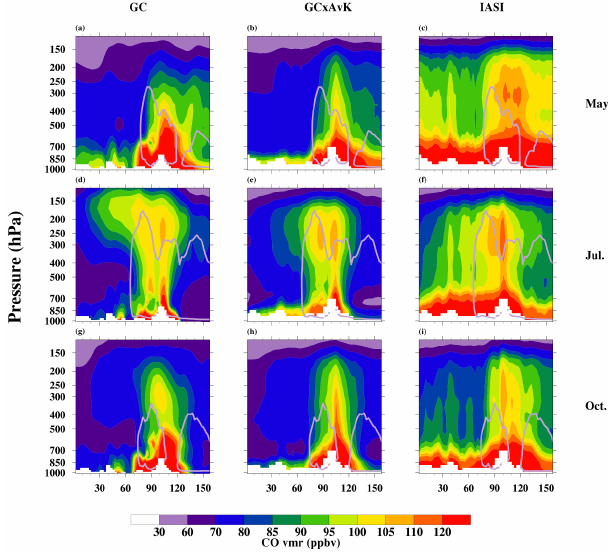
Figure 3. Latitude–pressure cross sections of CO mixing ratios av- eraged over 75–105 ◦ E: (a, d, g) GEOS-Chem; (b, e, h) GEOS- Chem smoothed with IASI averaging kernels; (c, f, i) IASI. From top to bottom, panels correspond to monthly periods with (a, b, c) May, (d, e, f) July and (g, h, i) October. The grey solid line represents the 2.5kgm − 2 s − 1 convective upward mass flux from